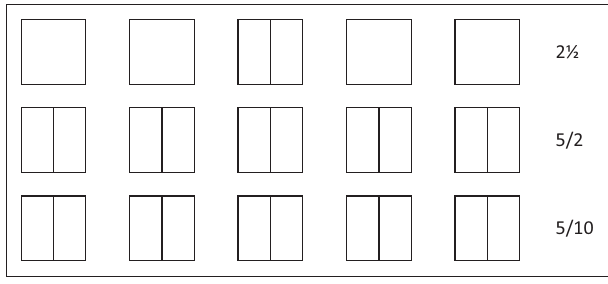
FIGURE 2: Responses to sharing five slices of bread between two